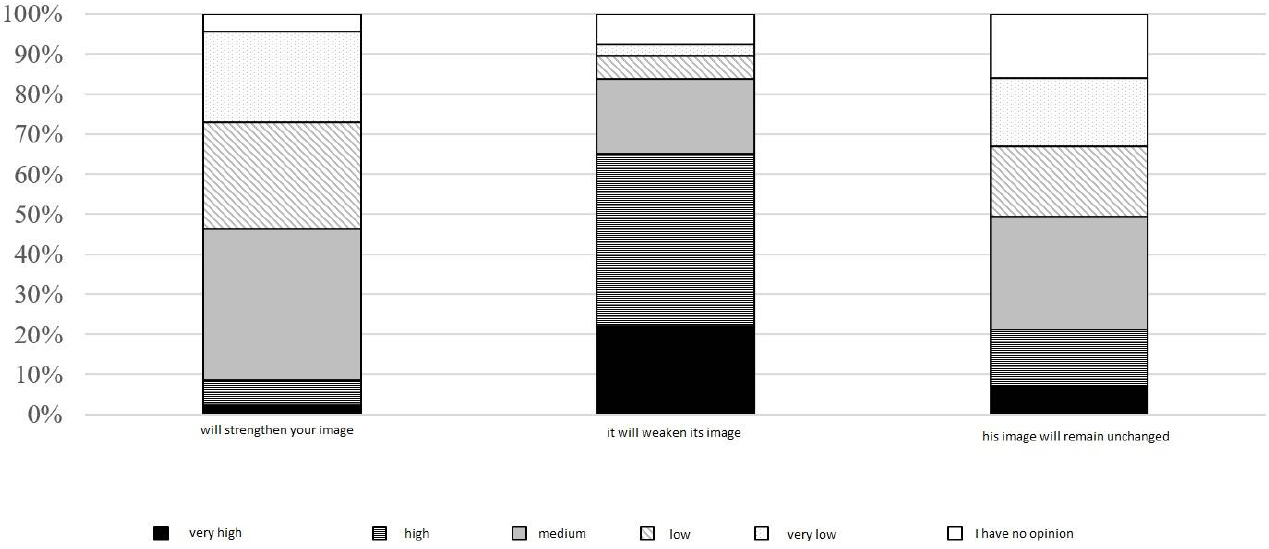
Figure 6. Expectations regarding the image of the Catholic Church in Poland in the future. Source: authors’ own elaboration.